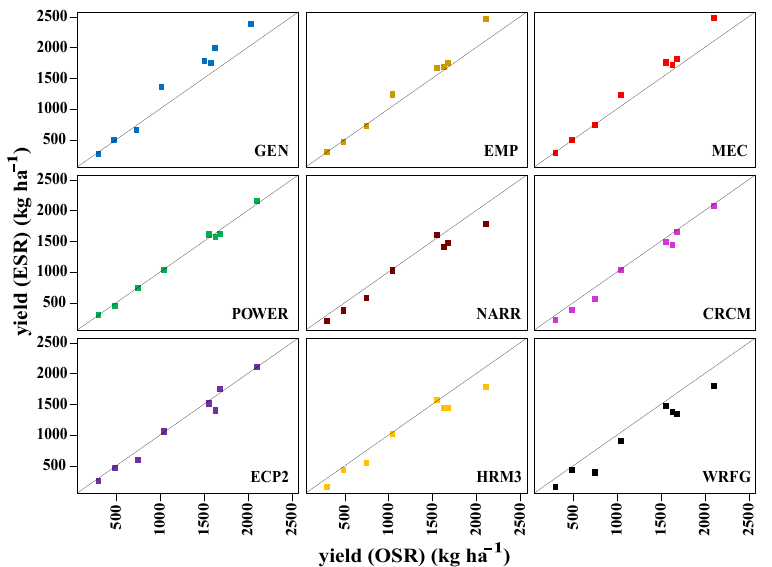
Figure 13. Soybean yield (kg ha −1 ) for the eight-­‐‑year analysis period simulated using daily solar radiation observations and estimates as input to CROPGRO−Soybean. OSR and ESR refer to observed and estimated solar radiation, respectively. Note: the simulated yields for the empirical and the mechanistic models were combined for the calibration and validation periods.